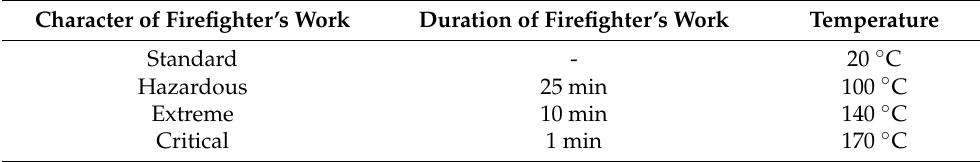
Table 2. Technical parameters affecting a firefighter